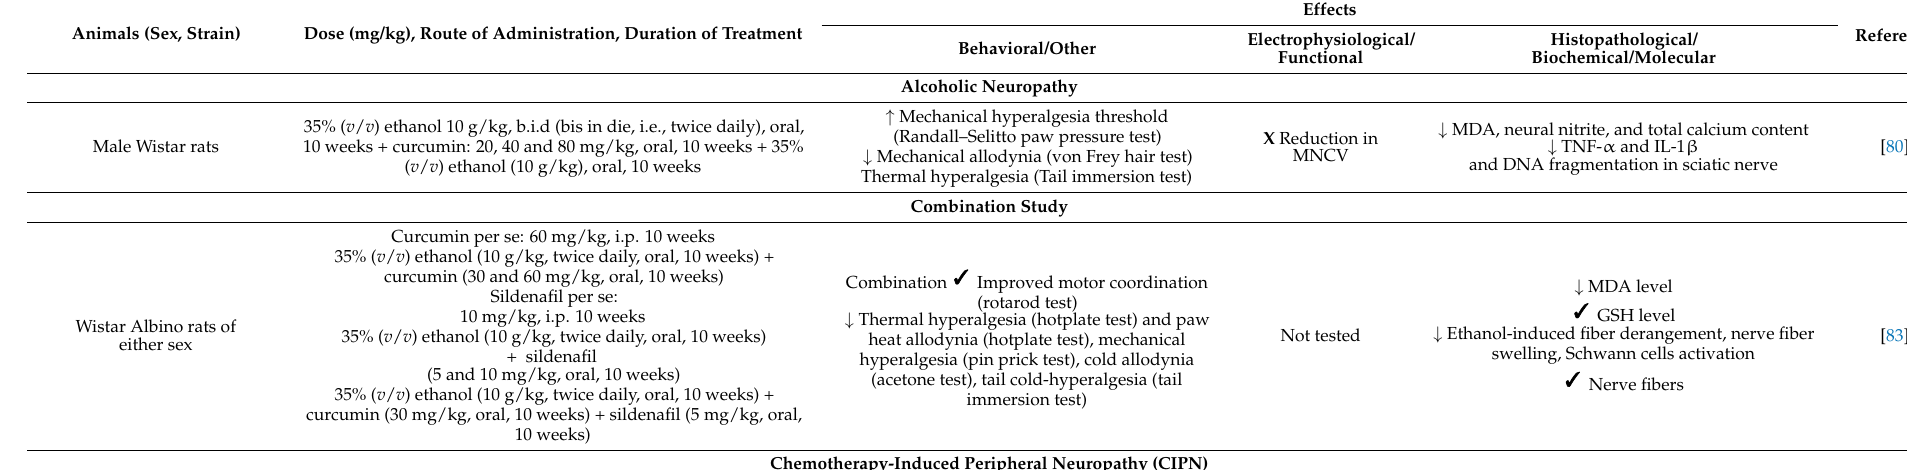
Table 2. Effects of curcumin on alcoholic neuropathy, chemotherapy-induced peripheral neuropathy (CIPN), and diabetic painful neuropathy (DPN). Animals (Sex, Dose (mg/kg), Route of Administration, Du- Strain) ration of